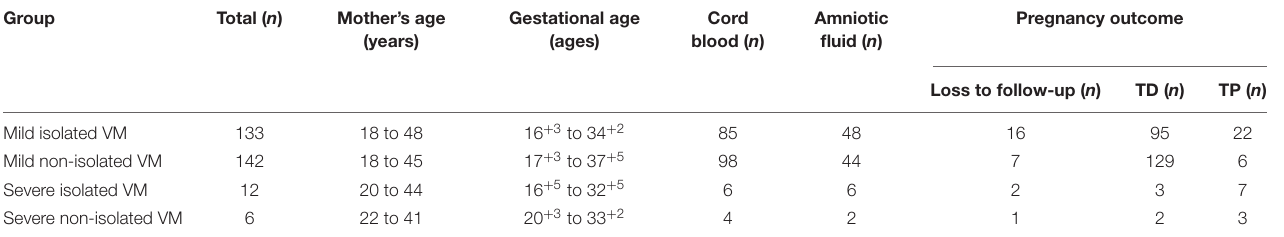
TABLE 1 | The demographic characteristics for all four